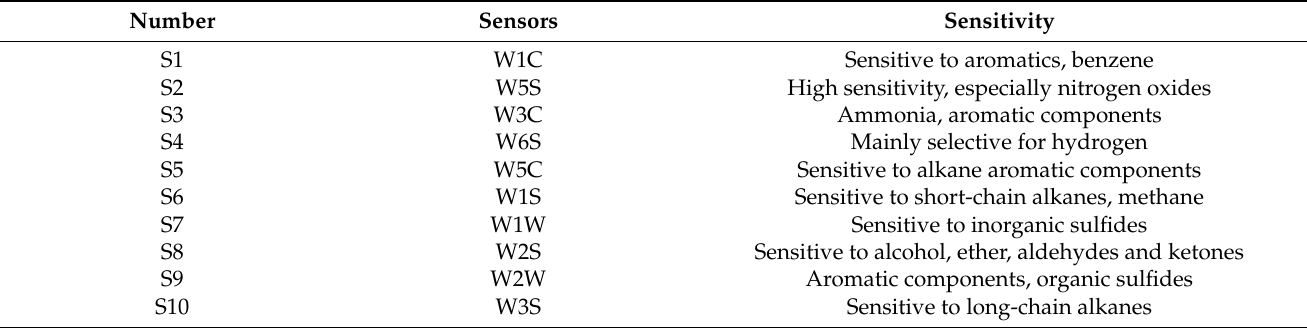
Table 2. The description of E-nose sensor